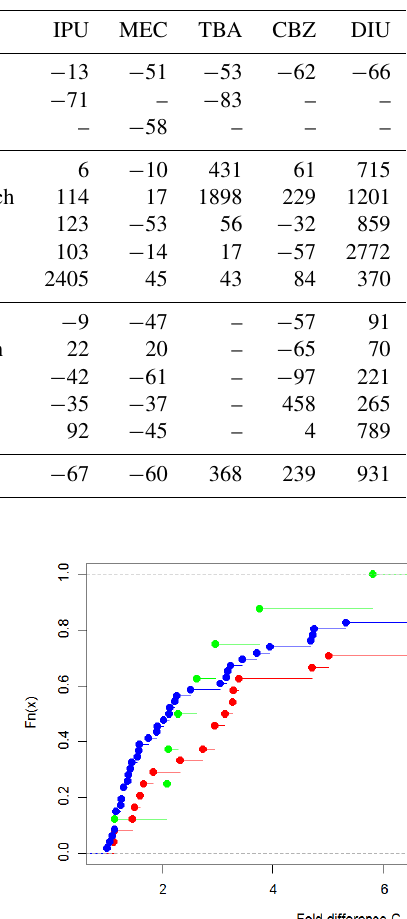
Table 4. Over- or underestimation of maximum concentrations (site–compound combinations) in percentage of the observations. For the herbicides, only the peaks during spring application were considered. IPU: isoproturon, MEC: S-metolachlor, TBA: terbuthylazine, CBZ: carbendazim, DIU: diuron. NADUF: National long-term surveillance of Swiss rivers, NAWA SPEZ: NAWA SPEZ: National Surface Water Quality Monitoring Programme – Special Campaigns, IRMS: International Rhine Monitoring Station (Basel).